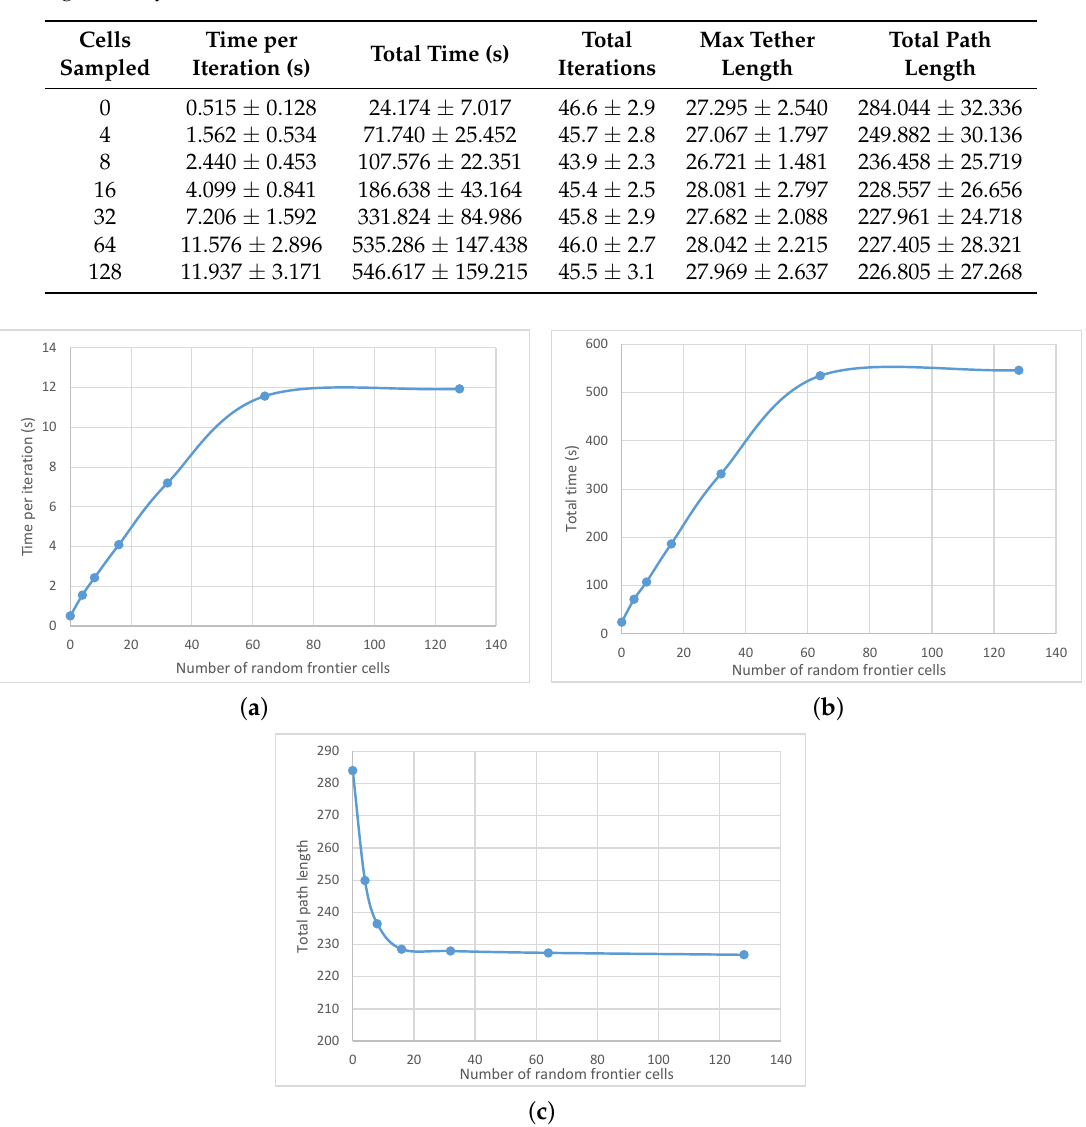
Table 5. Results using varying numbers of random frontier cells at ∆ L = 2 π R in a high-density environment.